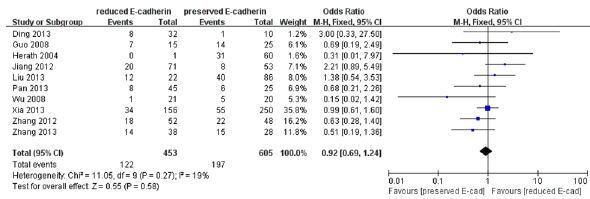
Figure 7. Forest plot displaying the results of the meta-analysis on TMN stage.